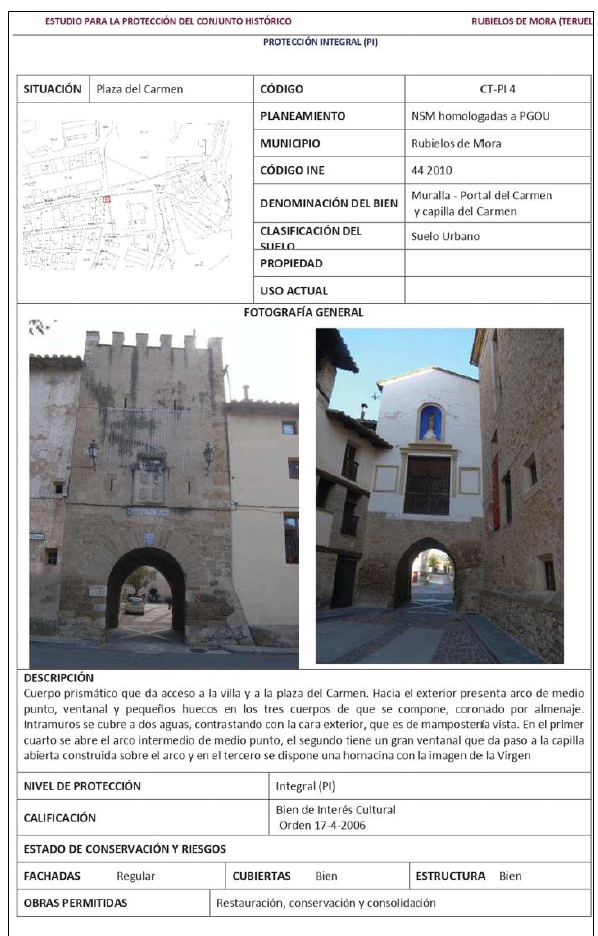
Figure 4. Inventory card. Remains of the medieval town walls of Rubielos de Mora (Sanz Zaragoza,